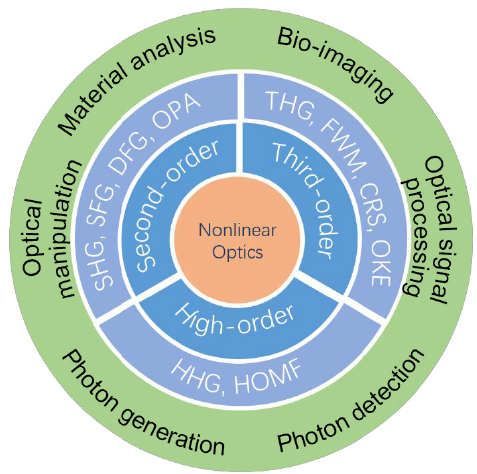
Fig. 1 | Typical examples of nonlinear optics processes and